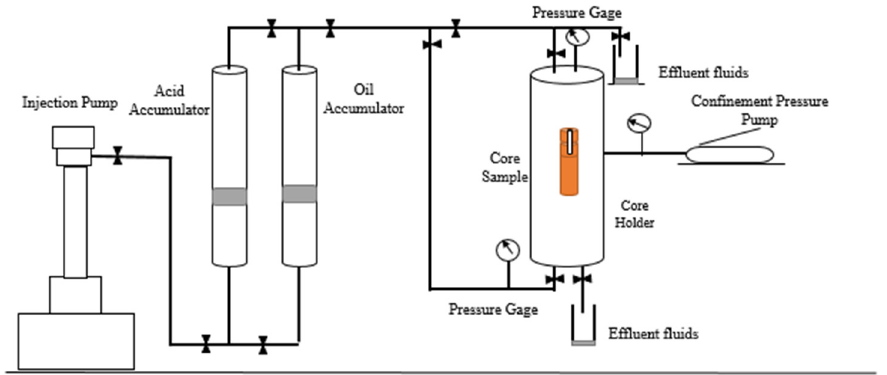
Figure 3. Core flooding setup schematic.